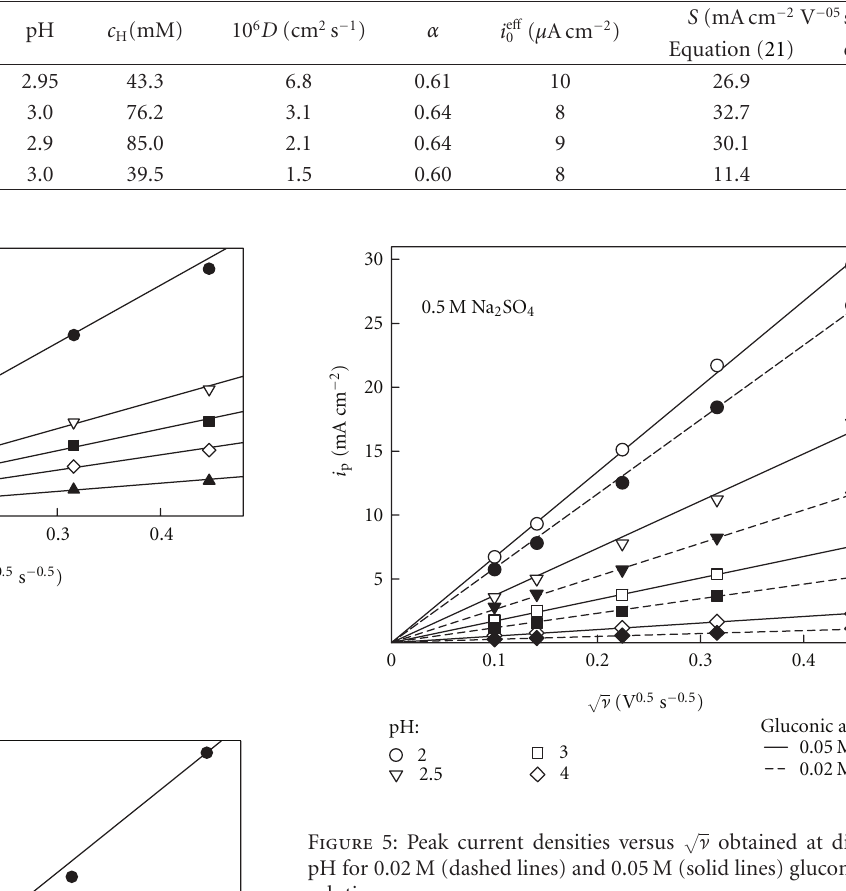
Figure 5: Peak current densities versus pH for 0.02 M (dashed lines) and 0.05 M (solid lines) gluconic acid solutions.